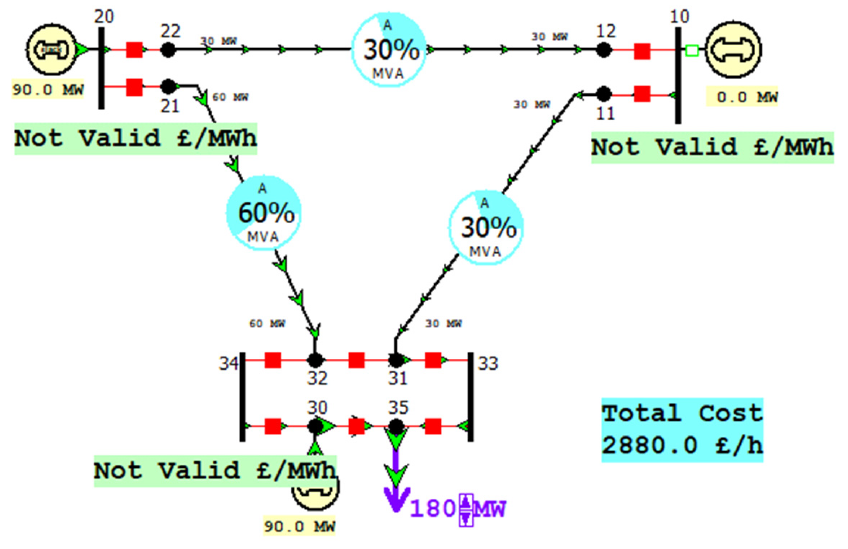
Figure 7. Attack scenario when two generators are tripped.